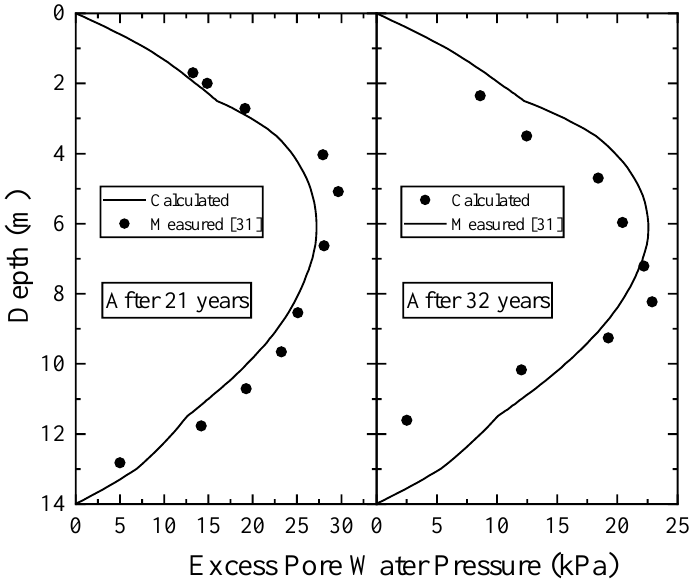
Figure 4. Comparisons of calculated and measured excess pore water pressure along time.